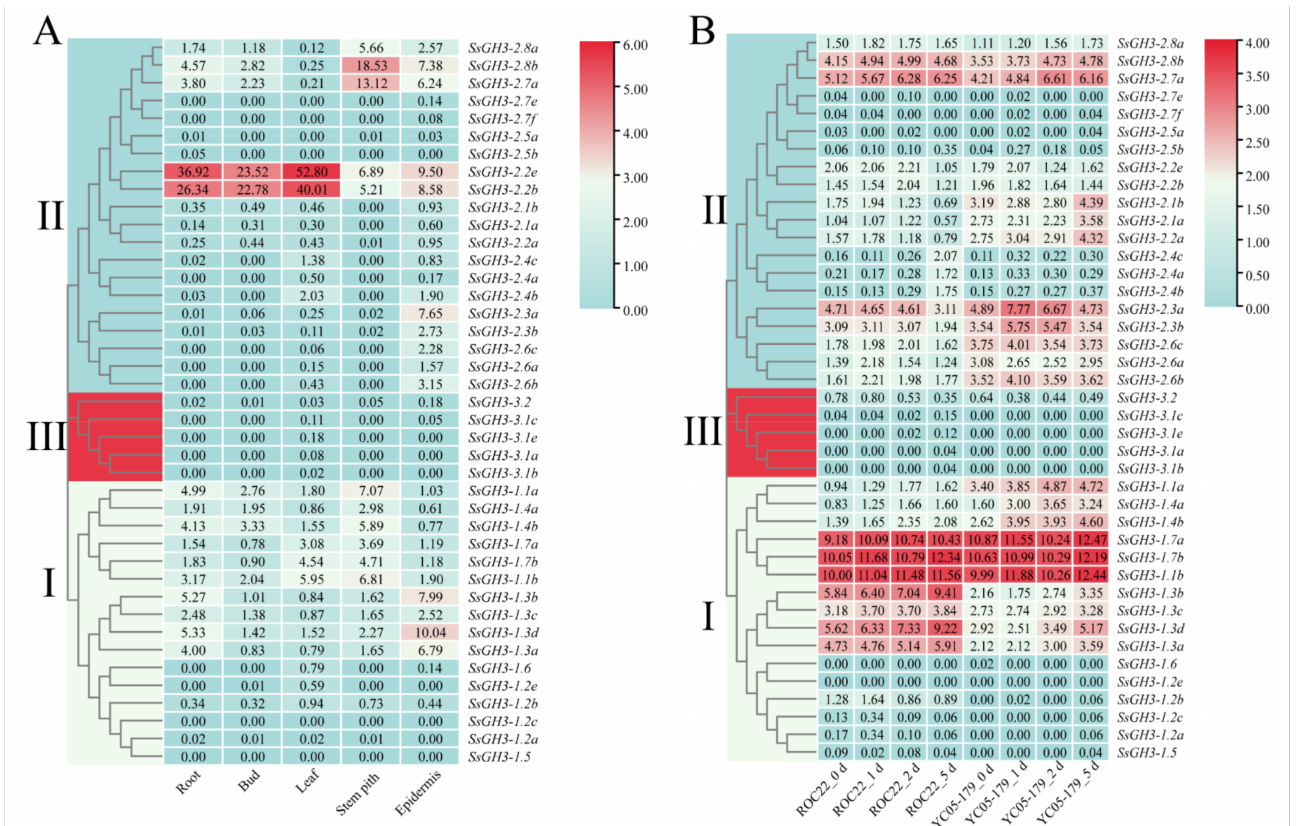
Figure 6. Expression patterns of the SsGH3 gene family in sugarcane, based on RNA-seq. ( A ) Tissue expression patterns of the SsGH3 gene family in the sugarcane cultivar ROC22. ( B ) Expression patterns of SsGH3 gene family in the interaction between different sugarcane genotypes and S. scitamineum . ROC22_0 d/1 d/2 d/5 d and YC05–179_0 d/1 d/2 d/5 d represent the sugarcane smut- susceptible cultivar ROC22 and smut-resistant cultivar YC05–179 under S . scitamineum